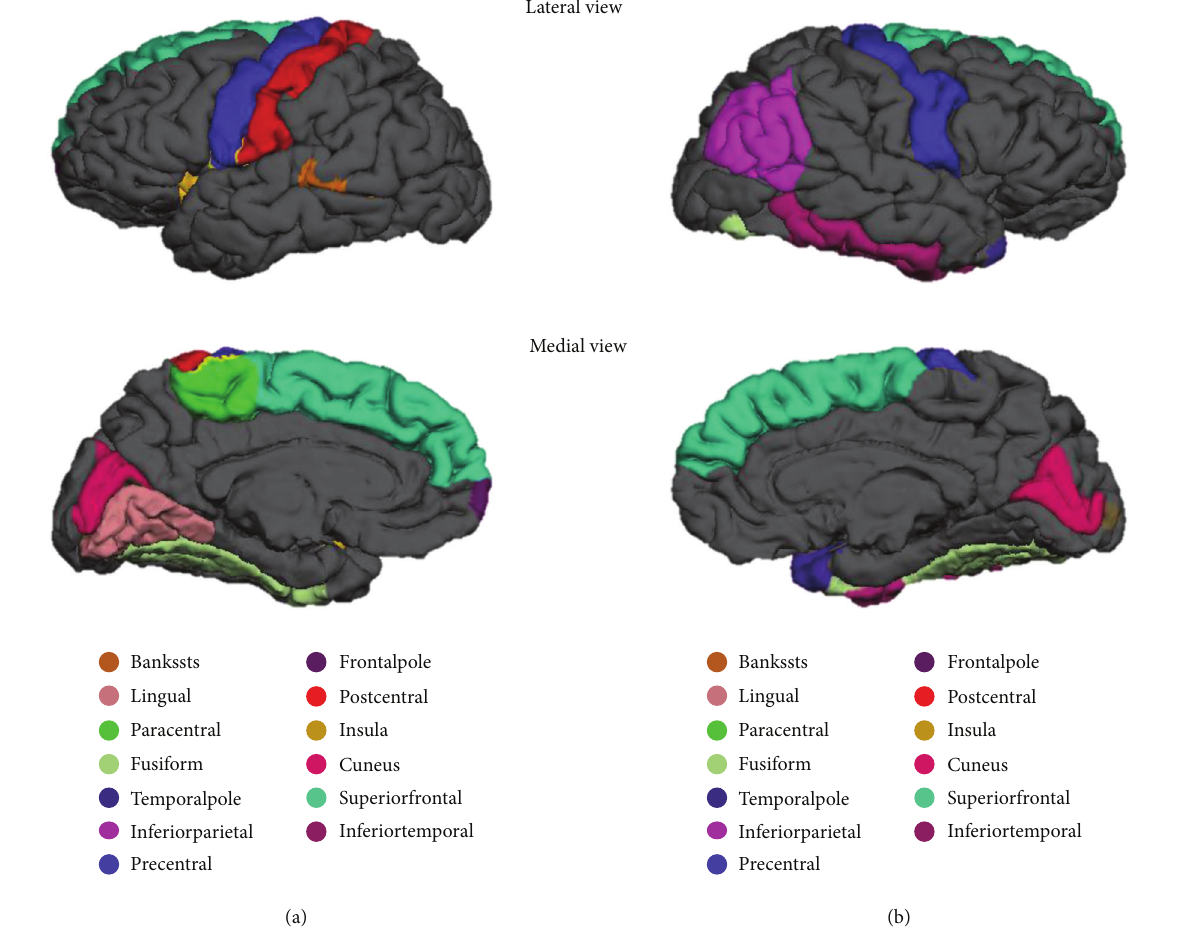
Figure 4: Representation of all significant surface area based on total-area normalized data on Table 7. (a) Left hemisphere (b) Right hemisphere.